Question: Which visualization type does this figure use?
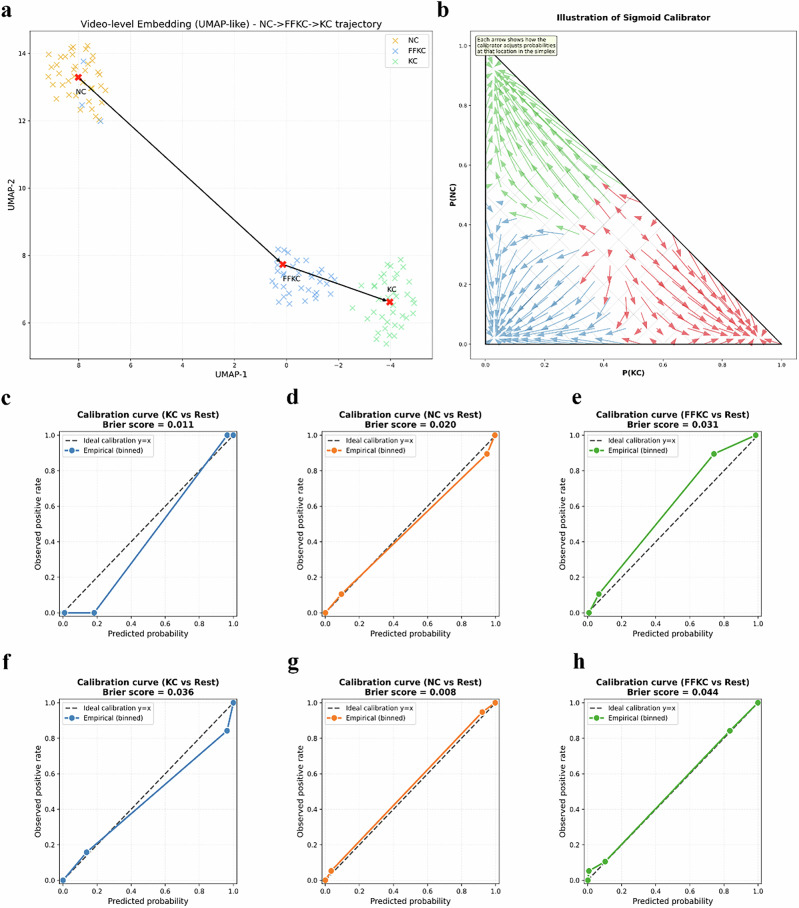
Answer: scatter